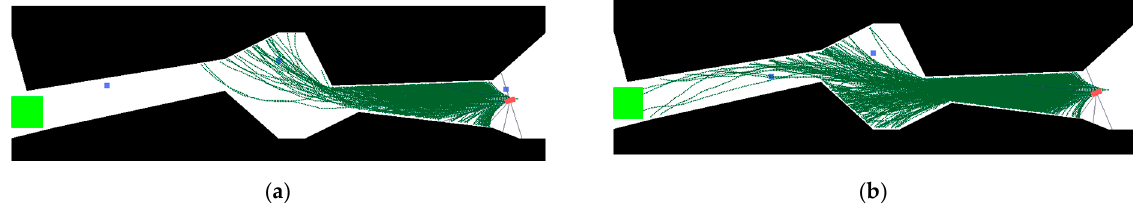
Figure 7. Environment 1. : The walls of unknown underwater canyon;